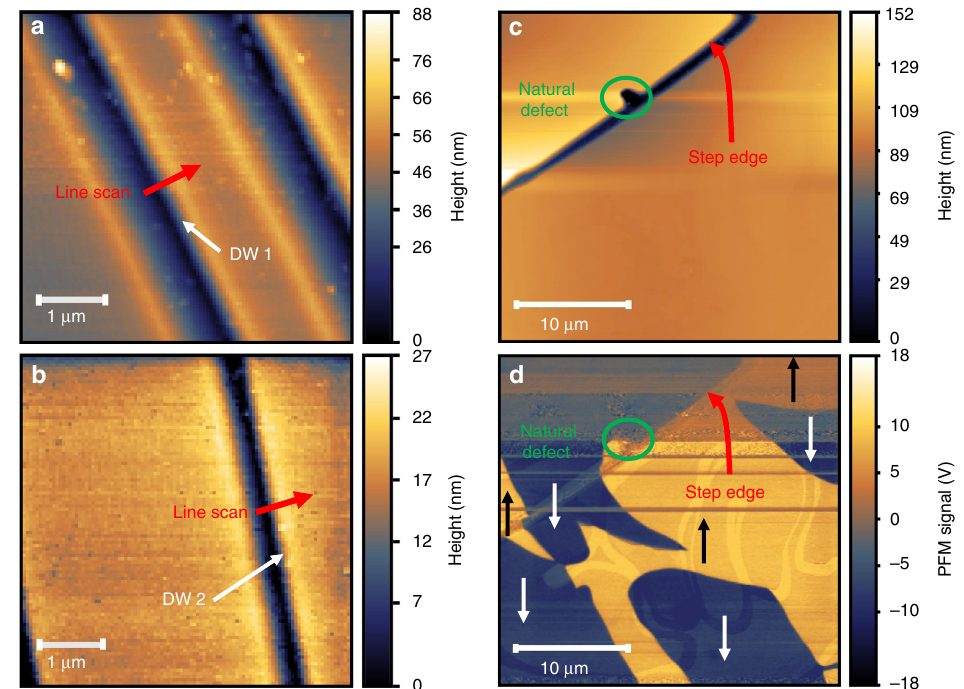
Fig. 2 Combining scanning techniques to locate domain walls. a , b Atomic force microscopic (AFM) images of the crystal surfaces showing the two ferroelastic domain walls of interest (at the edges of the dark blue stripes). These ferroelastic walls separate domains of different spontaneous strain and are also 90 (cid:1) ferroelectric walls. DW 1 and DW 2 refer to domain walls 1 and 2. Red arrows indicate direction and path of the line scans. The nano- spectroscopic line scans are taken perpendicular to the wall, and the contact angle from one domain to another is 90 (cid:1) . c AFM topography of a smooth area near an identi fi ed surface defect (indicated by a green circle) and step edge of approximately 100 nm height (indicated with a red arrow) compared with d the piezoresponse force microscopic (PFM) image of the same area revealing the placement and orientation of the 180 (cid:1) ferroelectric domains, indicated by yellow( + ) or blue( − ) regions with black or white arrows to indicate the polarization direction. All of these structures are present at room